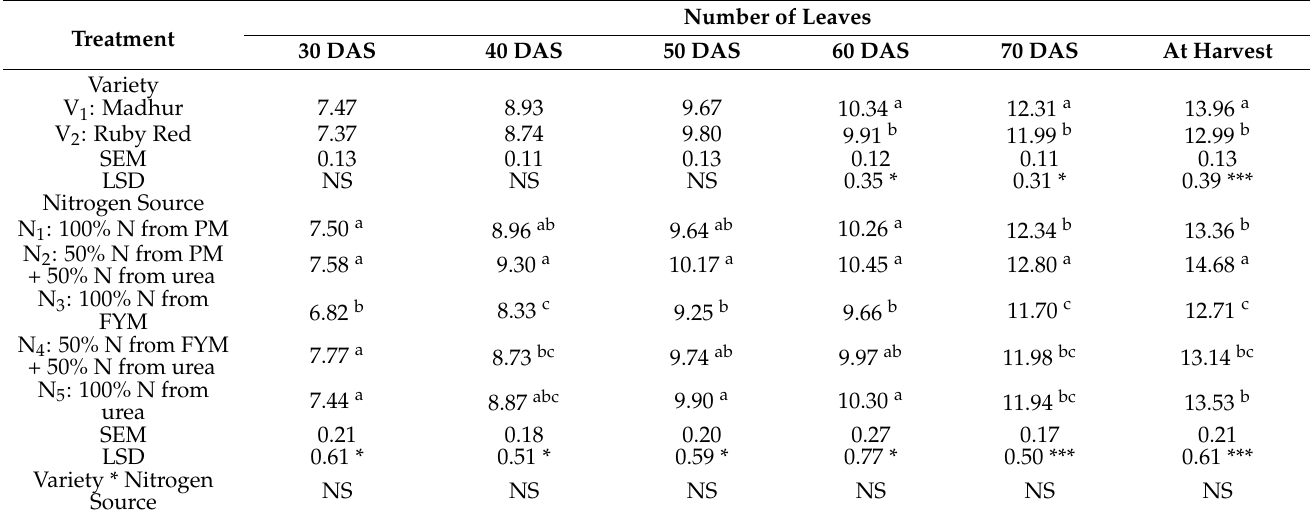
Table 2. Effect of variety and nitrogen source on number of leaves at different stages of beetroot at AFU, Rampur, Chitwan in